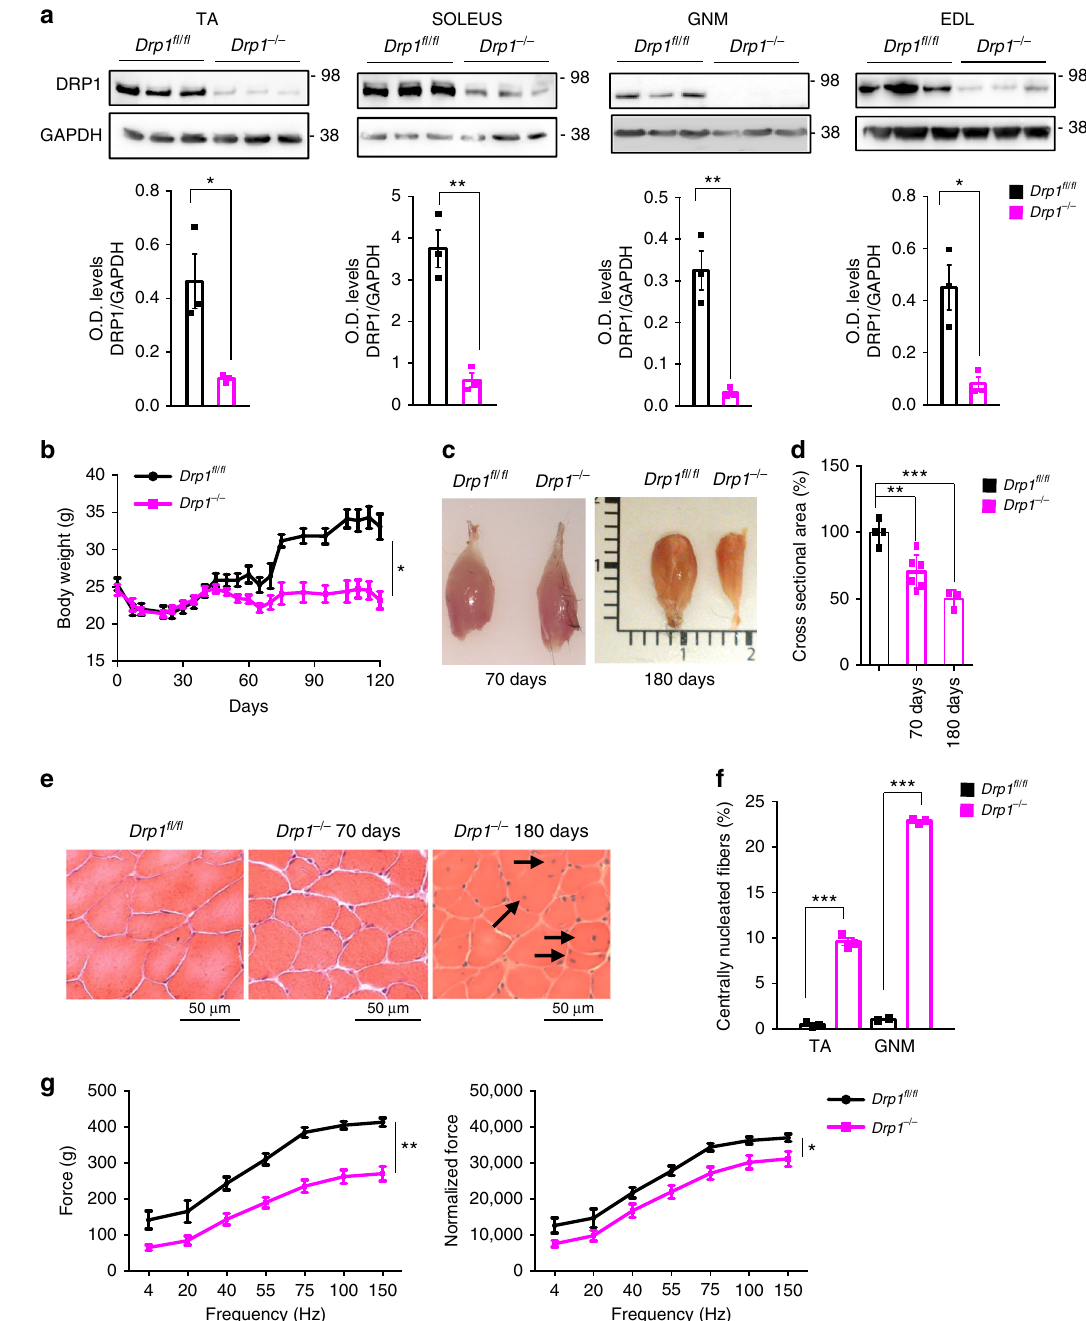
Fig. 4 DRP1 loss in adult animals causes body weight loss, muscle atrophy and muscle weakness. a DRP1 protein levels are downregulated in different types of skeletal muscles in HSADRP1-null mice. O.D. levels represent the average of at least three independent experiments ± SEM. b Growth curve of control and Drp1 − / − littermates during and after tamoxifen treatment. KO mice start to lose body weight after 7 weeks of tamoxifen treatment and during the following weeks. The data represent average ± SEM (WT, n = 10; KO, n = 11). c Dissected gastrocnemius muscles from the control and DRP1-null mice show an important muscle atrophy after DRP1 deletion in adult animals. d Quanti fi cation of the cross-sectional area of myo fi bers indicates a signi fi cant reduction in DRP1-ablated muscles. Values represent average ± SEM (WT, n = 5; KO 70 days, n = 5; KO 180 days, n = 3). e Representative haematoxilin – eosin staining of Tibialis Anterior muscle showing signs of myo fi ber degeneration/regeneration in Drp1 − / − after 180 days of treatment. f In Drp1 − / − muscles after 180 days of treatment, there are 10 and 25% of myo fi bers are centrally nucleated, in tibialis anterior muscle and gastrocnemius muscle, respectively ( n = 3 mice each condition). g Force measurements performed in vivo on gastrocnemius muscles. Absence of DRP1 leads to a signi fi cant decrease in both absolute force and maximal speci fi c force generated during tetanic contraction. The data represent average ± SEM ( n = 3). Two-tailed unpaired Student ’ s t test and two-way analysis of variant (ANOVA) were used. Statistical signi fi cance: * p ≤ 0.05; ** p ≤